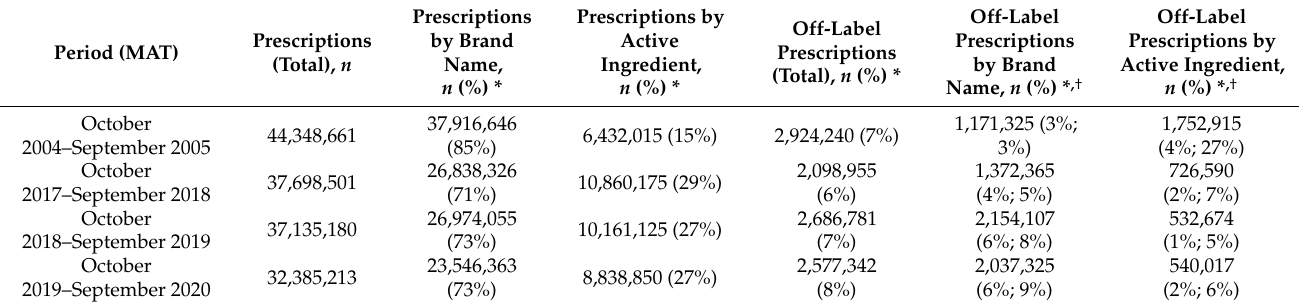
* Percentage calculated over total prescriptions in the under-18 population; † Percentage calculated over prescriptions by brand name or active ingredient in the under-18 population. Abbreviations: MAT, moving annual total (12-month period).